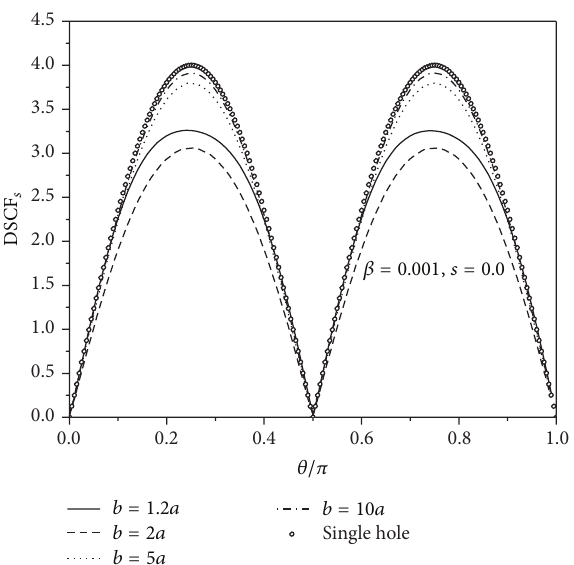
Figure 11: Distribution of DSCF along the middle hole for different separation of 𝑏 for 𝛽 = 𝜋/2 and 𝑠 = 0